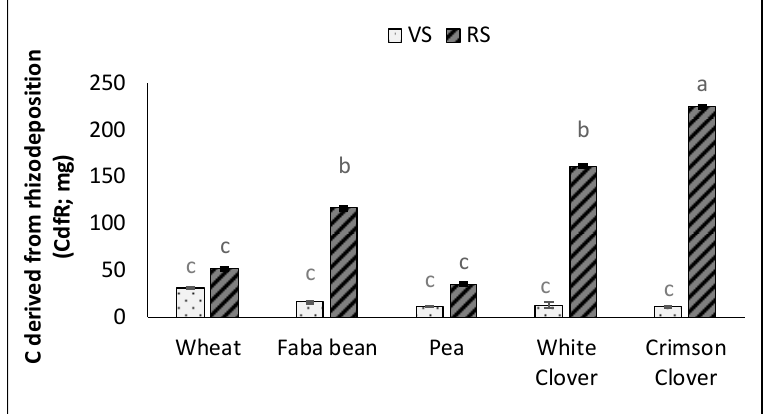
Figure 6. Soil C derived from rhizodeposition (CdfR) under all plants species at the two stages of development (mg.pot − 1 ). VS: vegetative stage; RS: reproductive stage. Data are mean ± SD (n = 5). Letters indicate statistical significant difference between plants species at p < 0.05 according to Tukey’s test.